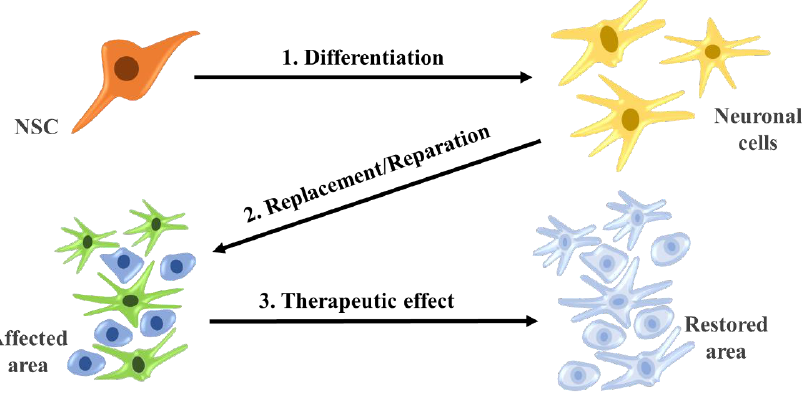
Figure 4. Differentiate and reparation of neural stem cells with therapeutic effects.